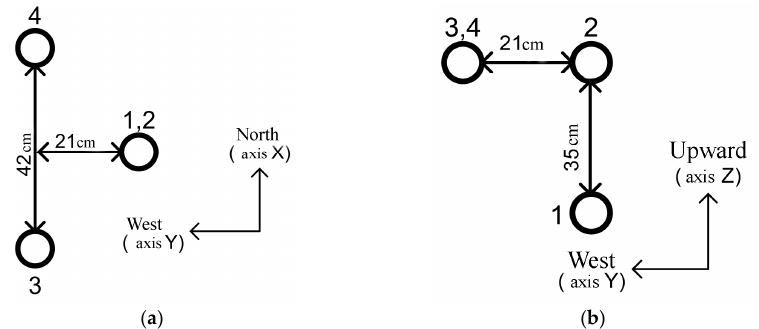
Figure 2. The scheme of spatial placement in the complex AMK-03-4 of ultrasonic measuring heads UGI-75 with serial numbers 1, 2, 3, and 4: ( a )—top view; ( b )—side view in the direction of north.